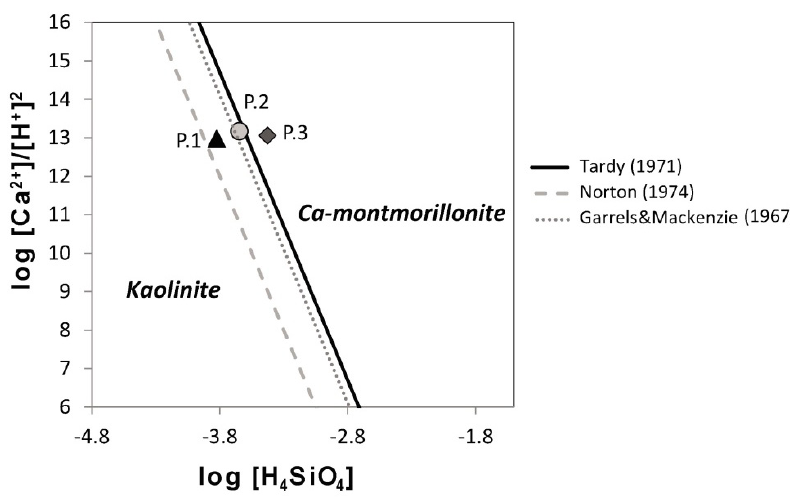
Figure 10. Stability diagram plot to evaluate the water composition in terms of water–rock equilibrium. The triangle, circle, and diamond correspond to points 1, 2, and 3, respectively, of the November 2014 sampling campaign.